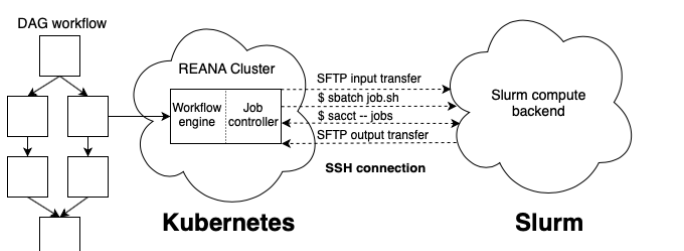
Figure 3. The typical interaction between REANA platform (running on Kubernetes) and Slurm com- pute backend (if a job is dispatched